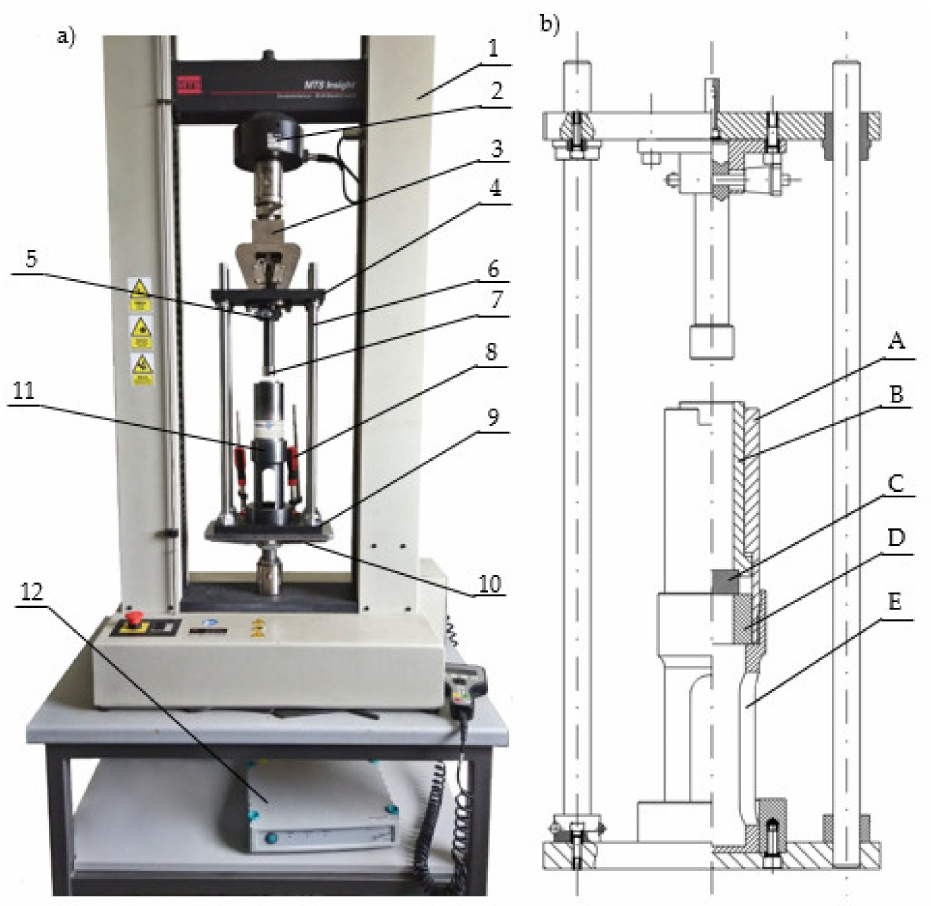
Figure 2. Testing station for the examination of the elastic modulus of dry ice as a function of the density. ( a ) 1: MTS durometer; 2: machine sensor; 3: machine grip; 4: upper plate; 5: Kipp locking pin; 6: guide assembly; 7: piston; 8: clamps; 9: lower plate; 10: machine base; 11: compacting sleeve assembly; 12: Spider 8 instrumentation amplifier. ( b ) Compacting sleeve assembly, cross-section view. A: upper sleeve; B: compacting chamber; C: compacting chamber bottom; D: spacer sleeve; E: lower